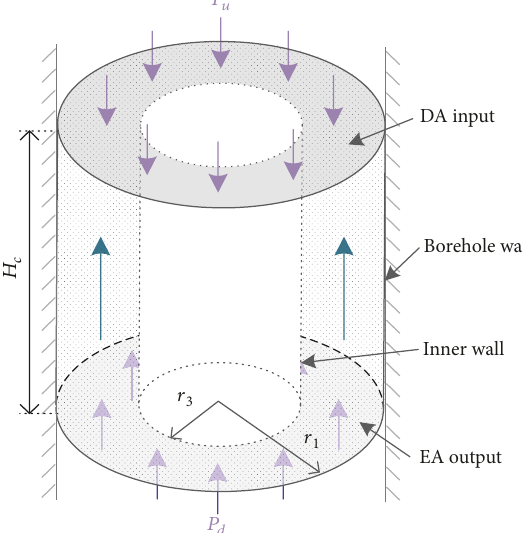
Figure 7: Stress of regolith in the storage